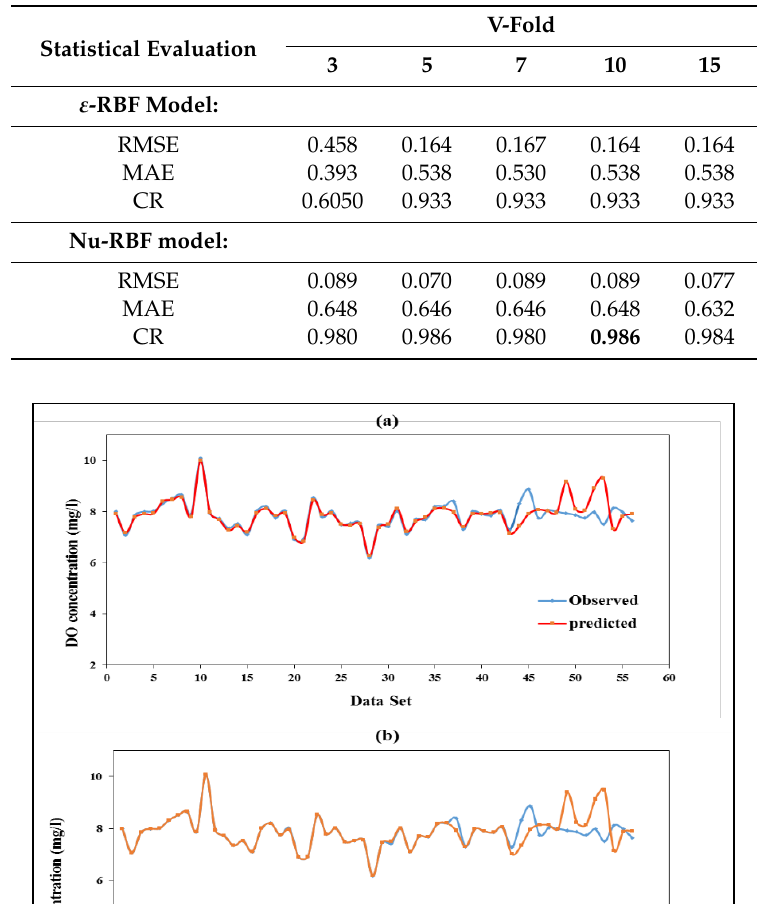
Table 5. Statistical evaluation using 3, 5, 7, 10, and 15-fold cross-validation for Epsilon-RBF and Nu-RBF models.